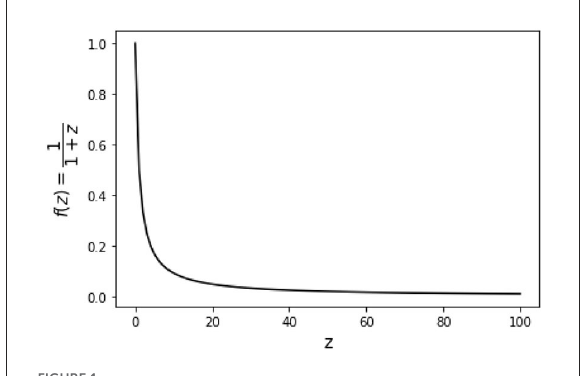
FIGURE1 Density-dependent Beverton-Holt